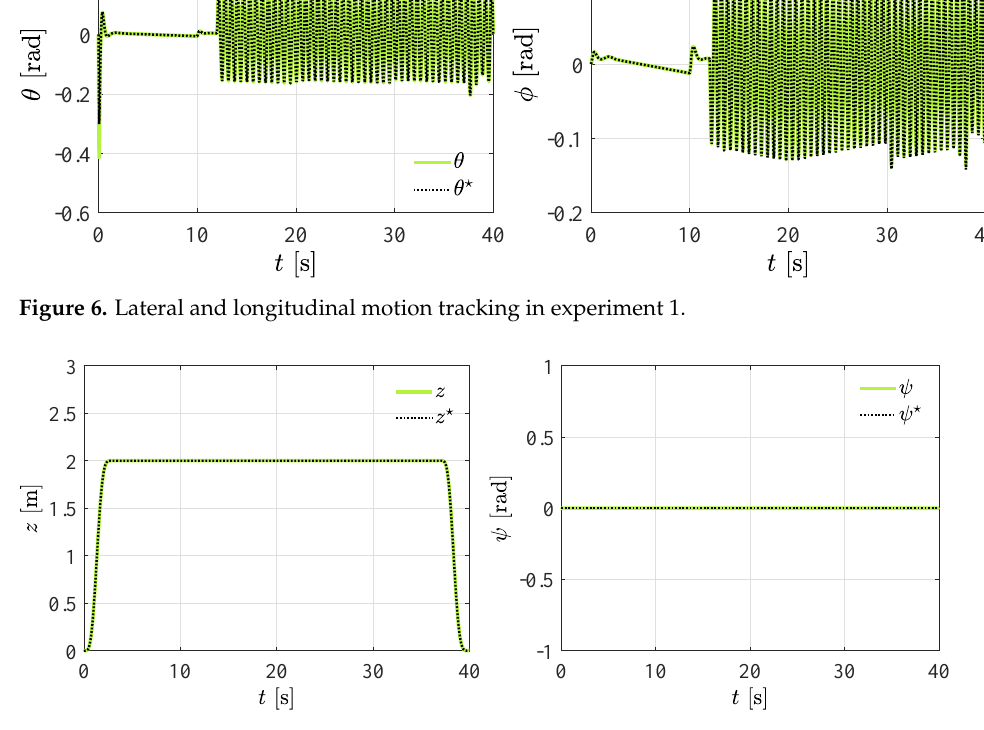
Figure 7. Vertical motion tracking for experiment